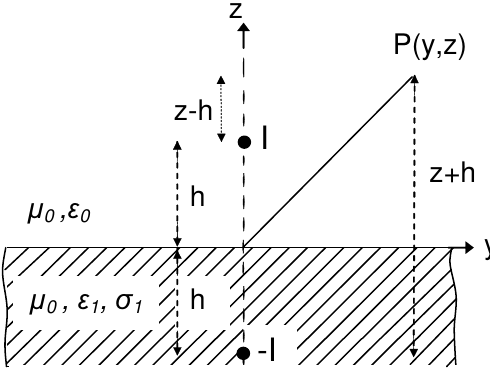
Figure 1. Sketch of a line source of current above a homogeneous